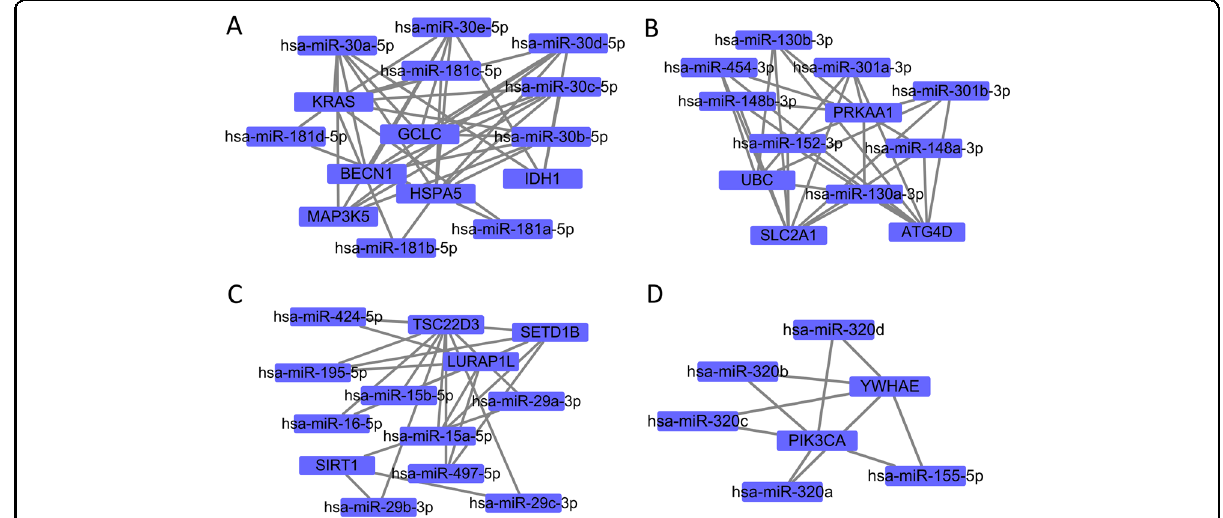
Fig. 8 Four densely connected regions in the networks identifying the four hub miRNAs based on the plug-in Molecular Complex Detection (MCODE) of Cytoscape. A hsa-miR-181d-5p; B hsa-miR-152-3p; C hsa-miR-497-5p; D